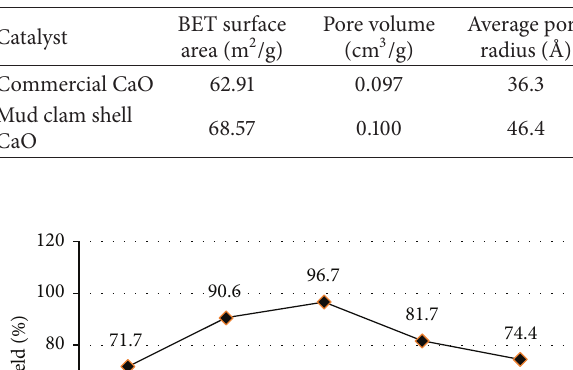
Figure 6: Catalyst concentration (%) versus biodiesel yield